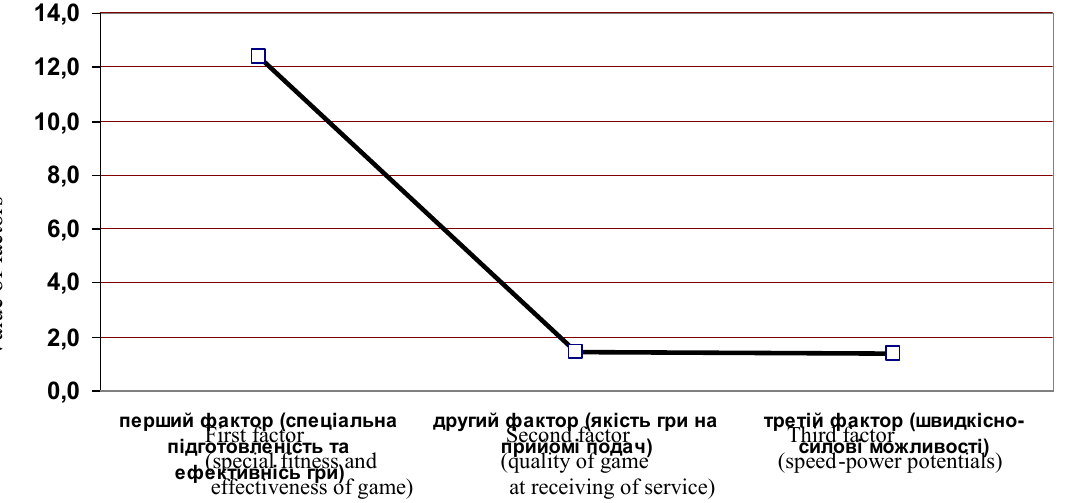
Fig.4. Values of factors in structure of tennis players’ physical and technical-tactic fitness at stage of specialized basic